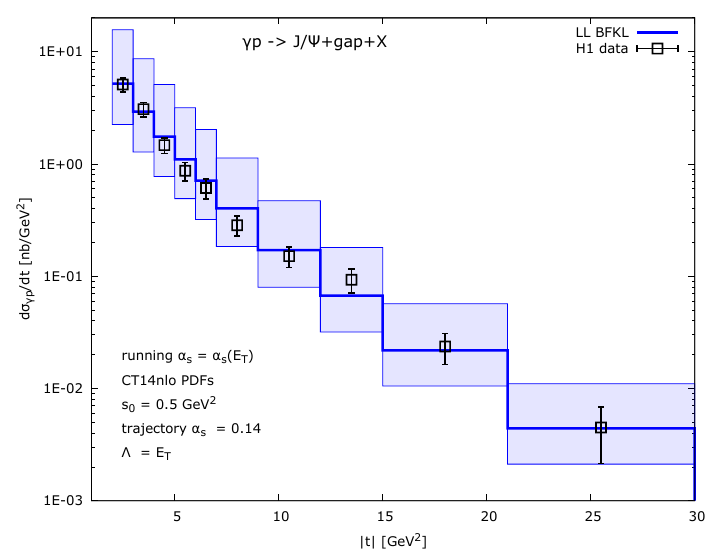
Figure 9 . The differential cross section dσ/dt for the diffractive J/ψ production vs H1 data [1] for the coupling constant entering the LL BFKL trajectory ¯ α s = 0 . 14.